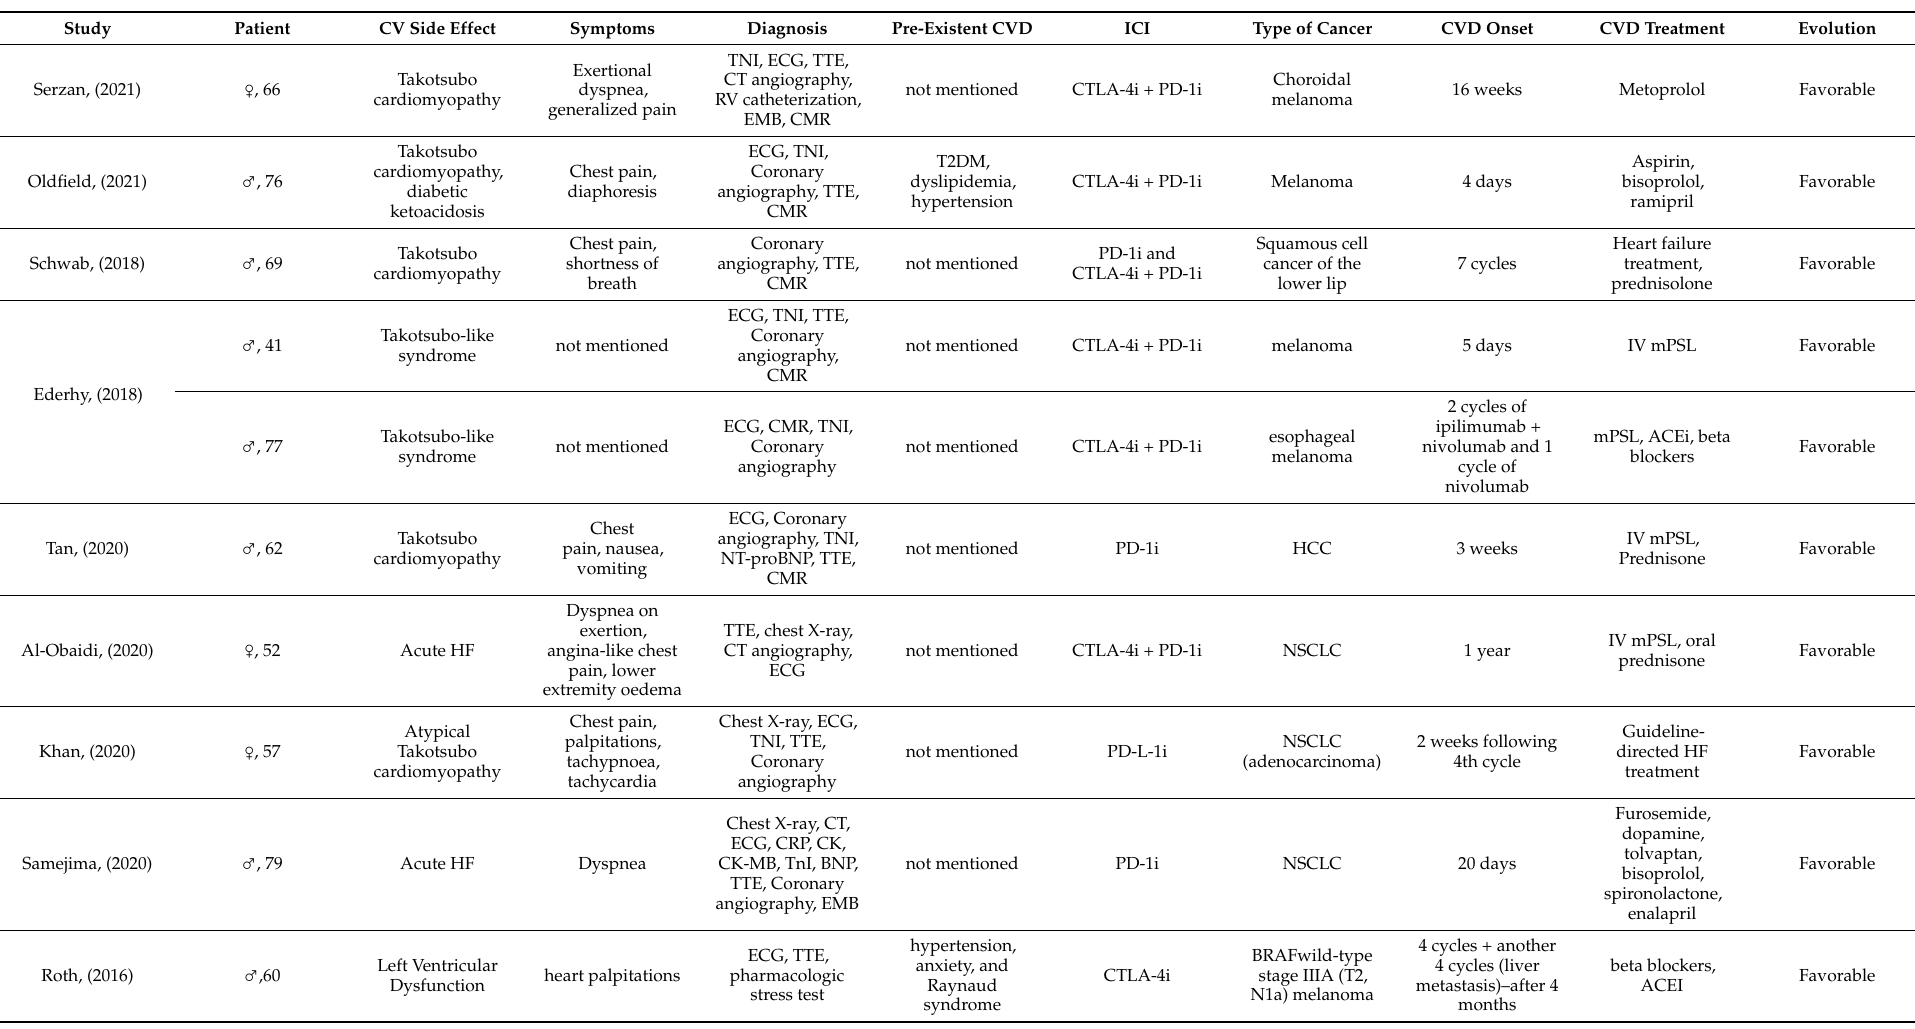
Table 4. Case reports with ICI-related